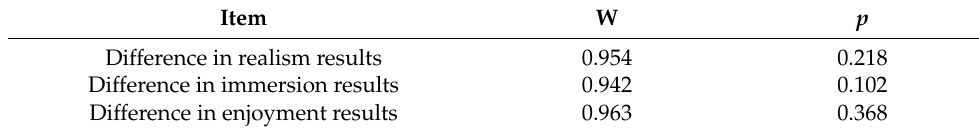
Table 4. Normality test results of the difference between Likert-scale result values. Item W p Difference in realism results 0.954 0.218 Difference in immersion results 0.942 0.102 Difference in enjoyment results 0.963